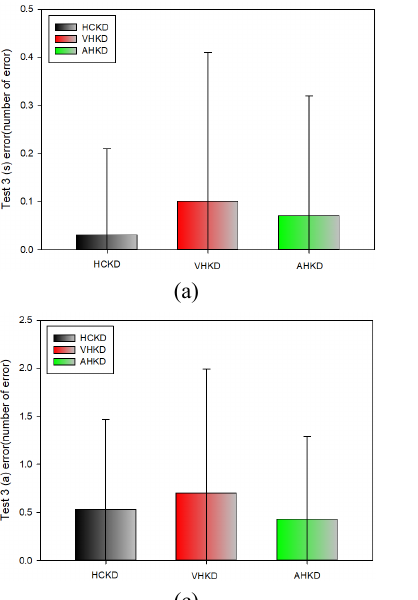
Figure 16. Frequency of error occurrence in Test 3(*: p <